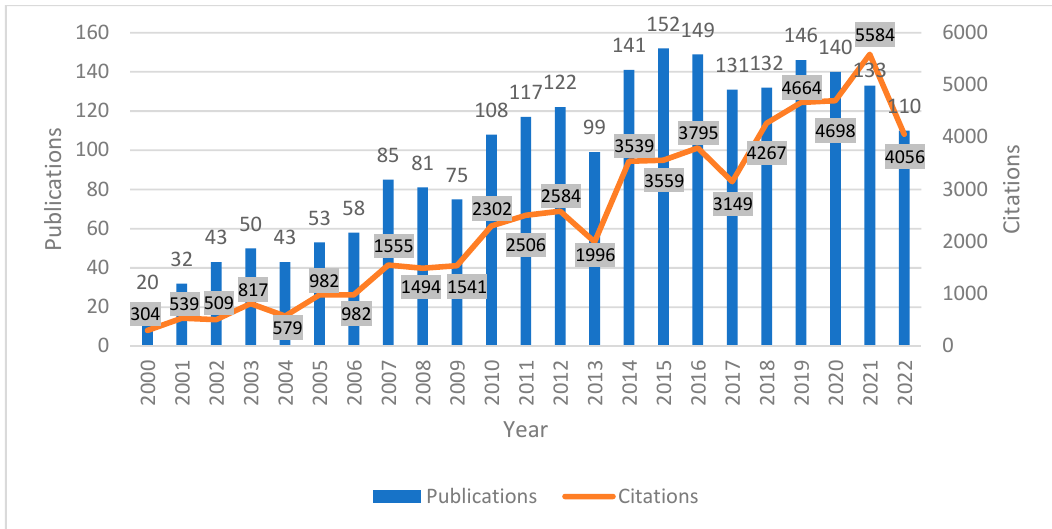
Figure 1. The evolution of publications and citations by year.